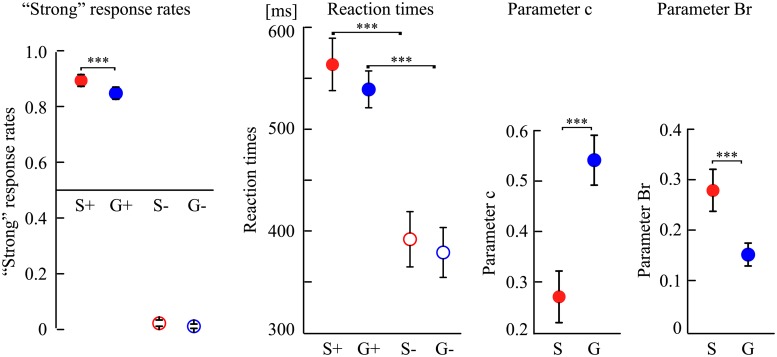
The “strong” response rates, reaction times, and inductive decision thresholds for each kind of arguments.S+ indicated arguments with specific congruent conclusion categories; G+ indicated arguments with generic congruent conclusion categories; S− indicated arguments with specific incongruent conclusion categories; and G− indicated arguments with generic incongruent conclusion categories. Error bars represent mean ± S.E.M. ***p < 0.001.